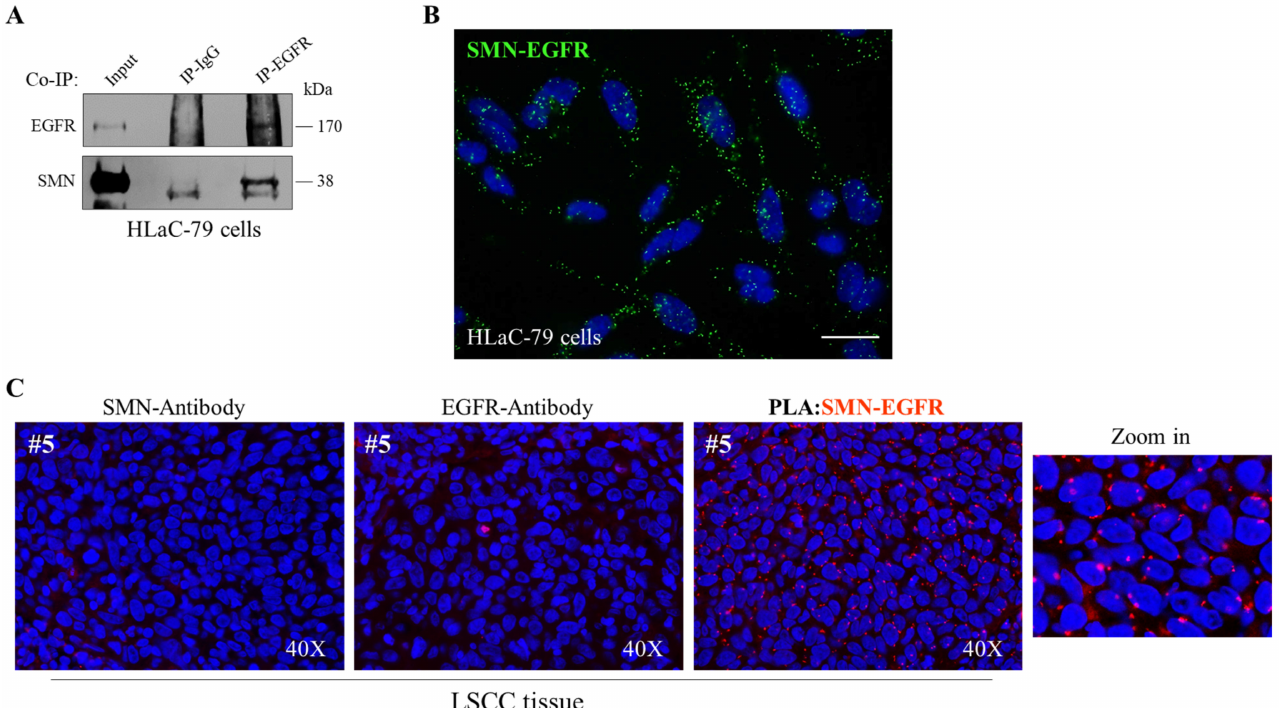
Figure 7. SMN interacts with EGFR in laryngeal squamous cell carcinoma. ( A ) Cellular extracts from HLaC-79 cells were processed for co-immunoprecipitation assay (Co-IP) using EGFR polyclonal antibody-conjugated beads (IP-EGFR) or rabbit IgG-conjugated beads (IgG), as negative control. Then, samples were subjected to Western blot analysis. The 5% of the protein extract was used as input. Representative immunoblotting of three independent experiments, showing the co-precipitation of SMN with EGFR. ( B ) Representative image of in situ proximity ligation assay (PLA) performed in HLaC-79 cells using primary antibodies against SMN and EGFR (mouse monoclonal antibody and rabbit polyclonal antibody, respectively). PLA puncta (green dots) are indicative of SMN-EGFR interaction sites. Nuclei were labeled with DAPI (blue). Scale bar 10 µ m. ( C ) Representative image of in situ proximity ligation assay (PLA) performed in de-paraffined sections of LSCC tissue from patient #5, using primary antibodies against SMN and EGFR (mouse monoclonal antibody and rabbit polyclonal antibody, respectively). PLA puncta (red dots) are indicative of SMN-EGFR interaction sites. As negative control, PLA was performed using only one of the primary antibodies (anti-SMN or anti-EGFR). Nuclei were labeled with DAPI (blue). Images were acquired with a 40 ×